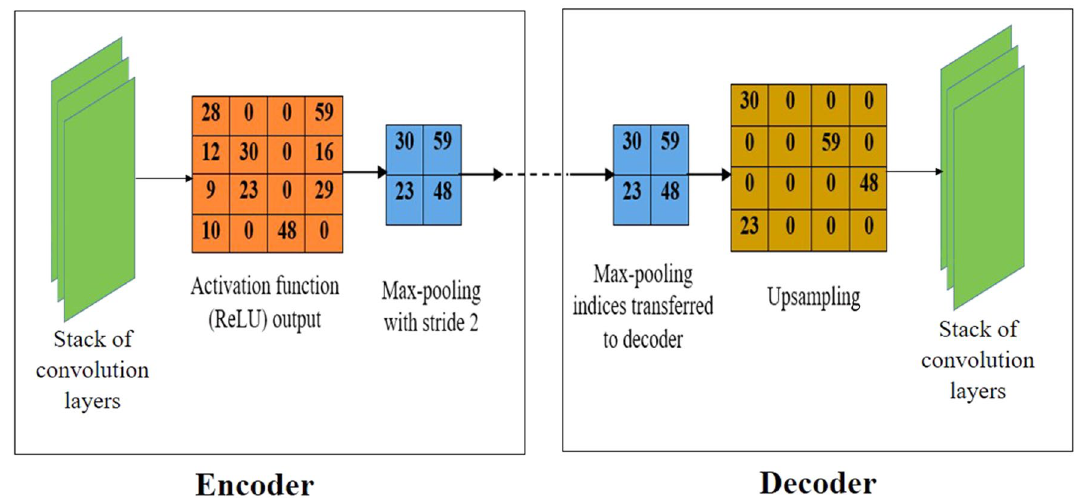
Figure 2. Upsampling operation in the proposed method of SegNet with